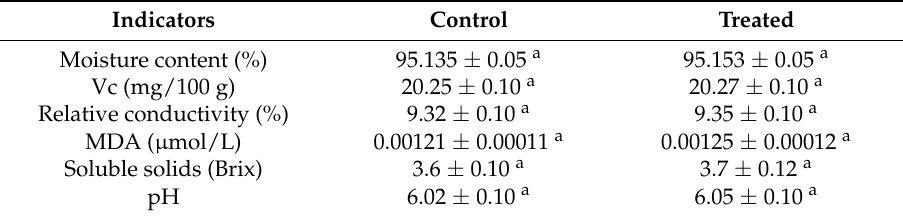
Table 1. Effect of APLTP treatment on the physicochemical properties of fresh-cut